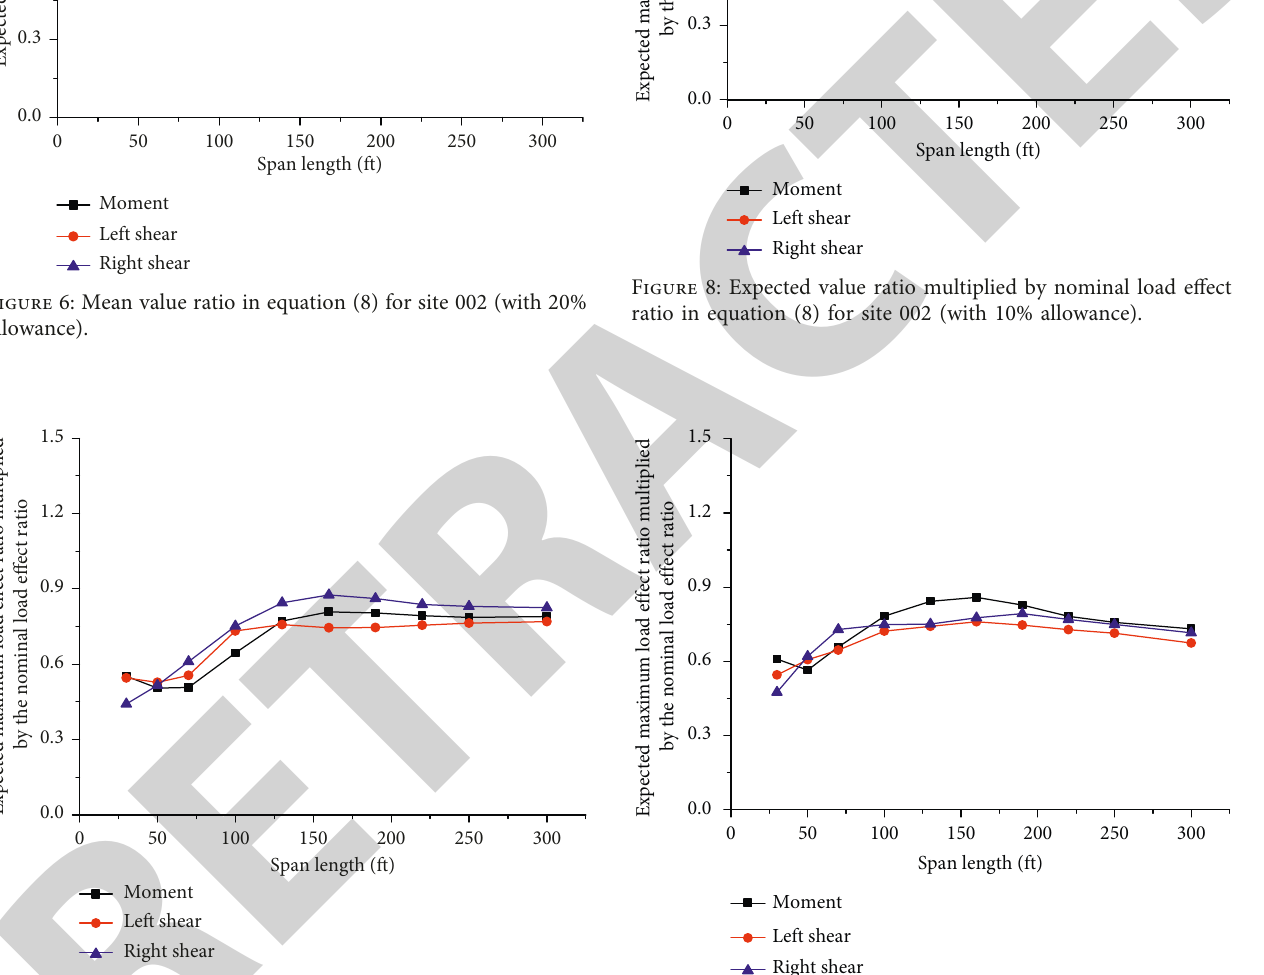
Figure 7: Expected value ratio multiplied by nominal load effect ratio in equation (8) for site 002 (with 0% allowance).